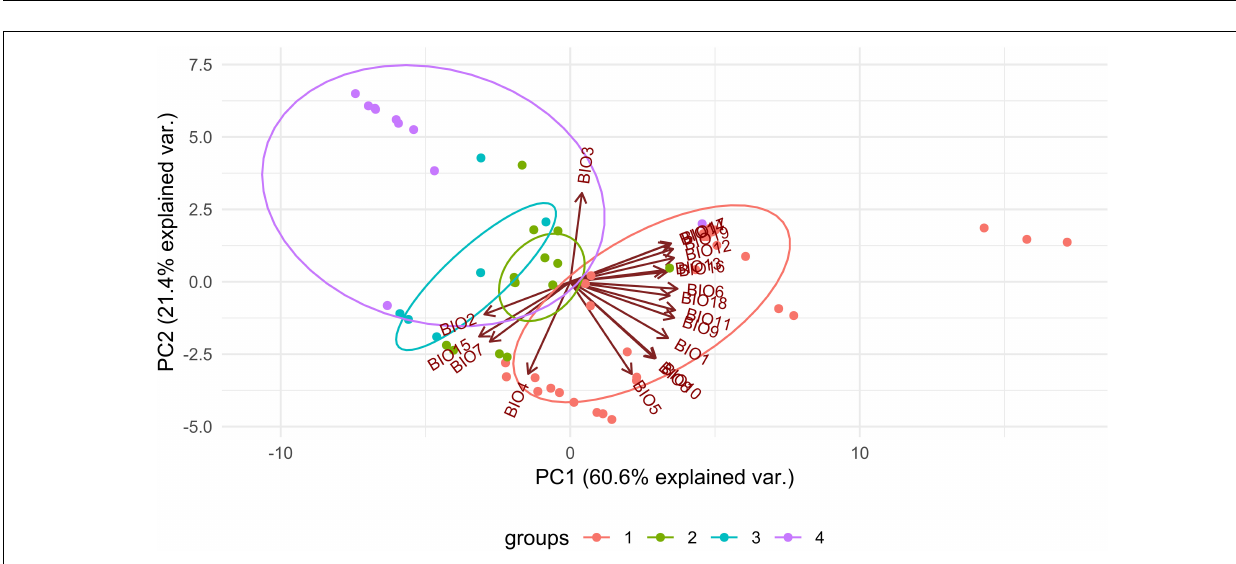
FIGURE 6 | PCA result of Trebouxia distribution depending on climatic factors and selected habitat types in Bolivia. 1—lower montane cloud forest, 445–1,943 m a.s.l, 2—upper montane cloud forest 1, 2,130–2,879 m a.s.l, 3—upper montane cloud forest 2, 3,000–3,893 m a.s.l and 4—open high Andean vegetation, 4,020–4,850 m